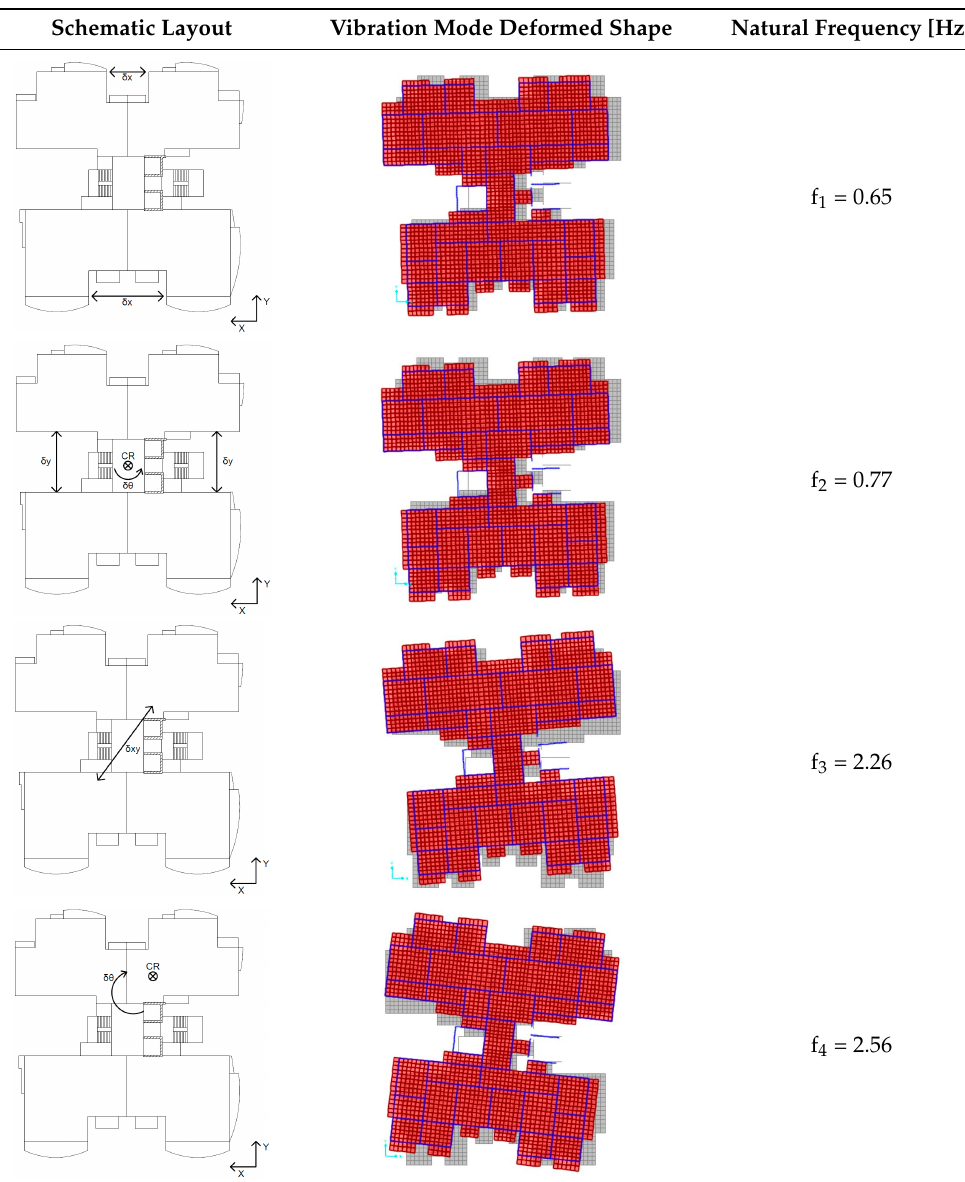
Table 6. Modal analysis results: model with infill masonry walls (damaged) – Model 3.